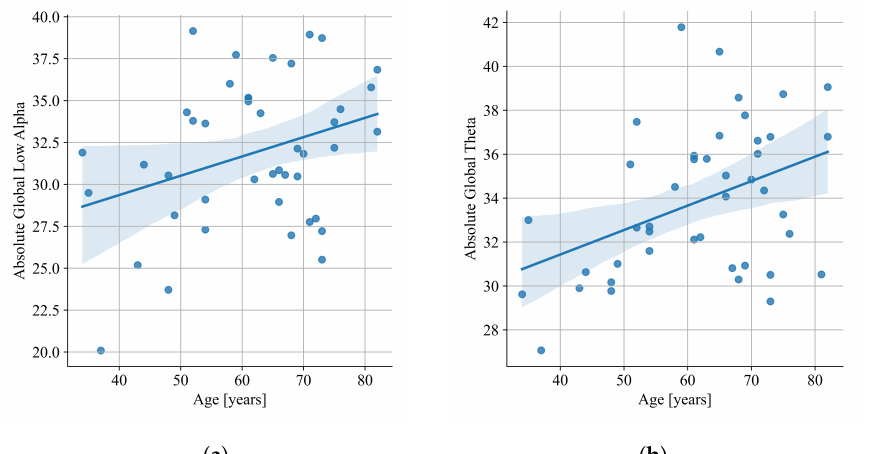
Figure 9. Linear regression of absolute global low alpha ( a ) and absolute global theta ( b ) versus age in PD-CogN group.